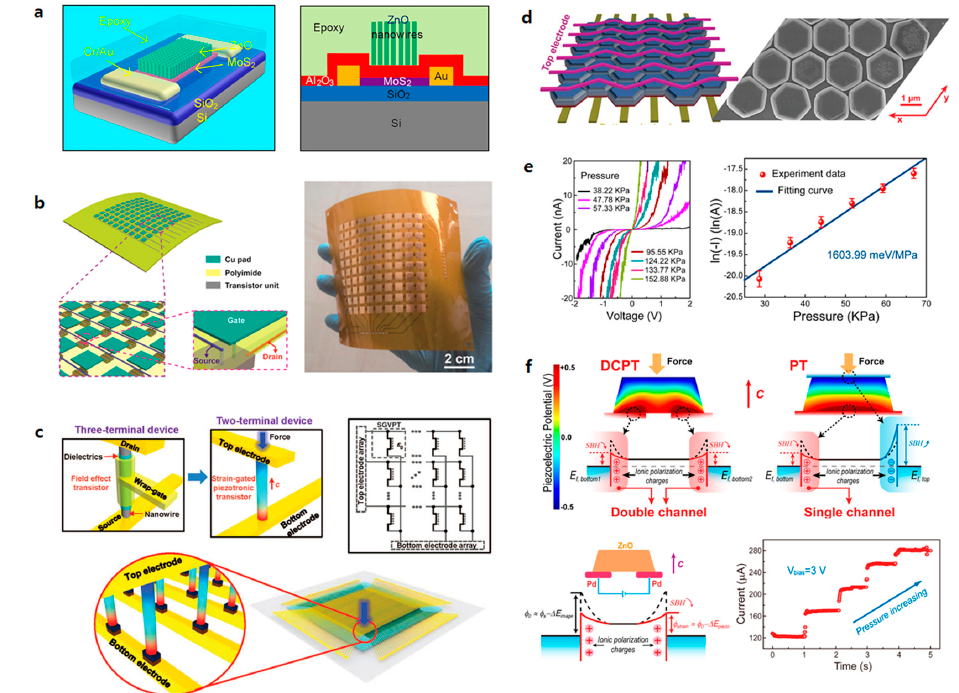
Figure 5. Transistor array using pressure-sensitive channel materials. ( a ) Schematic illustration of a FET based on a MoS 2 and ZnO heterostructure (left). Schematic cartoon graphs of the architecture of the device that uses the ZnO nanowire (NW) array and MoS 2 flake, separated by a 20-nm atomic layer deposition (ALD)-deposited Al 2 O 3 layer. ( b ) Schematic of a 10 × 10 tribotronic transistor array (TTA) (left). Partial enlarged tilted views of the TTA configuration and pixel structure, respectively (inset). Optical photograph of a fully integrated TTA with each sensing pixel of 5 × 5 mm (right). ( c ) Comparison between three-terminal voltage-gated NW FET and two-terminal strain-gated vertical piezotronic transistor (left). Color gradient in the strained strain-gated vertical piezotronic transistor (SGVPT) represents the strain-induced piezopotential field, in which red and blue indicate positive and negative piezopotential, respectively. ZnO NWs in SGVPT grow along the c axis (red arrow). Equivalent circuit diagram of the 3D SGVPT array (right). Equivalent circuit diagram of the 3D SGVPT array (bottom). The region highlighted by black dashed lines is the unit SGVPT device, in which ε g represents the mechanical strain gate signal and the vertical dotted line between the two terminals of the SGVPT denotes the modulation effect of ε g on the conducting characteristics of the device. ( d ) Schematic illustration of a 2D piezotronic transistor (2DPT) array using ZnO nanoplatelet (left). Scanning electron micrograph of 2DPT array with high spatial resolution ( ≈ 12,700 dpi) (right). ( e ) The modulation of carrier transport by pressure in a piezotronic transistor based on ZnO twin nanoplatelets, which shows the characteristic of piezotronic e ff ect (left). ln(I) − P curve demonstrates a linear relationship between ln(I) and the applied pressure, showing the extreme sensitivity and indicating the modulation effect of applied pressure on conductance (right). ( f ) Piezopotential distributions and the corresponding energy-band diagrams of double-channel piezotronic transistor (DCPT) and conventional piezotronic transistor (PT) (top). Compared to one rise and another drop in conventional PT, both Schottky barriers in DCPT decrease with increasing pressure. Energy-band diagram of DCPT without (black dashed line) and with (red line) piezotronic e ff ect, in which ∆ E image and ∆ E piezo represent mirror force and piezopotential-induced Schottky barrier height change, respectively (left). Current increased step-by-step with increasing pressure by a step of 63.5 kPa from 0.75 to 1.00 MPa at a fixed bias (right). ( a ) Reproduced with permission [86]. Copyright 2016, American Chemical Society ( b ) Reproduced with permission